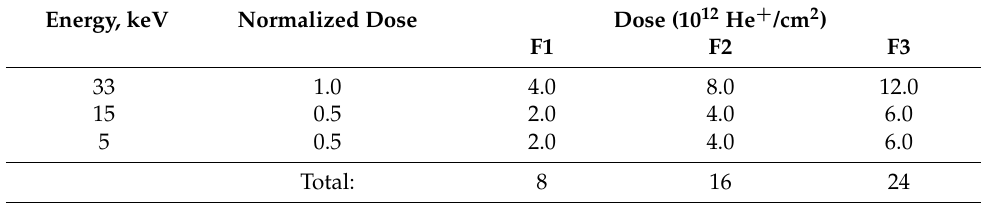
Figure 1. Fabrication of samples: ( a ) SRIM vacancy-depth profile for fabrication of 200-nm-thick NV layer close to the diamond surface. ( b ) Time–temperature graphs for the three annealing steps. Table 1. He ion implantation doses and energies used for fabrication of samples F1, F2, and